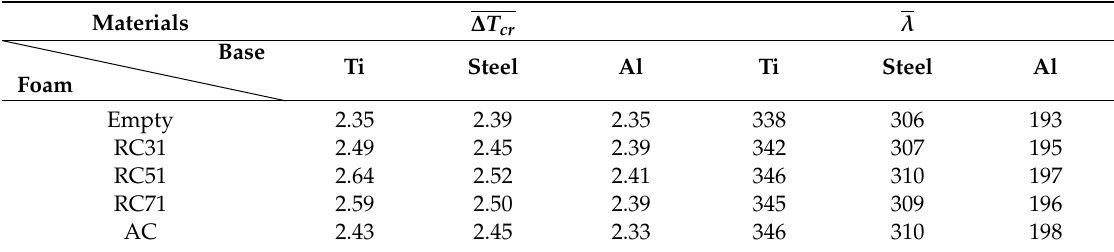
Table 3. E ff ects of material combination of foam and base structures on critical temperature change and dimensionless critical dynamic pressure with temperature change ∆ T = 100. Materials ∆ T cr λ Base Foam